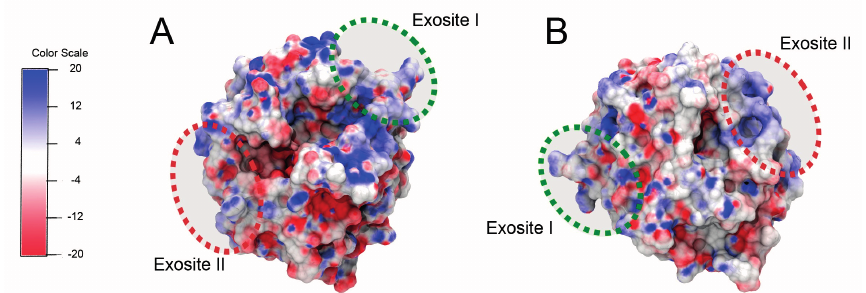
Figure 1. Thrombin structure (pdbID: 1ppb) [4]. ( A , B ) present two views of the protein. The binding sites of the aptamers (exosites I and II) are highlighted with green and red circles, respectively. Thrombin’s surface is colored by electrostatic potential, where red corresponds to negative potential and blue corresponds to a positive potential (units are kT/e) [5–7].